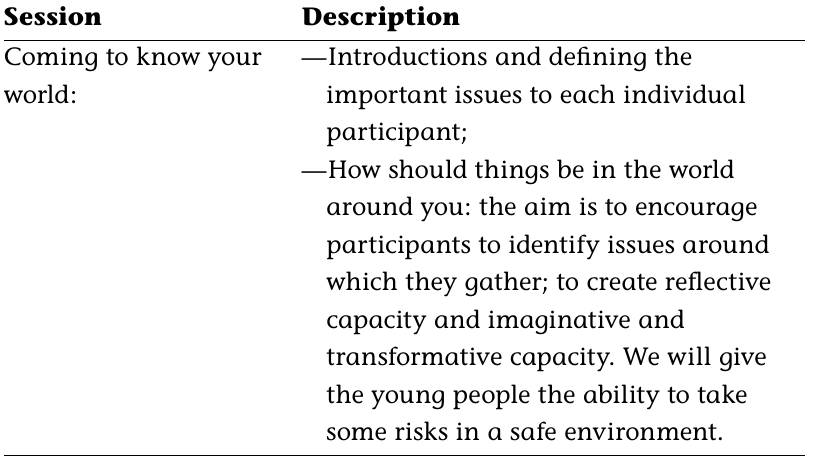
Table 1: Structure of the school-based